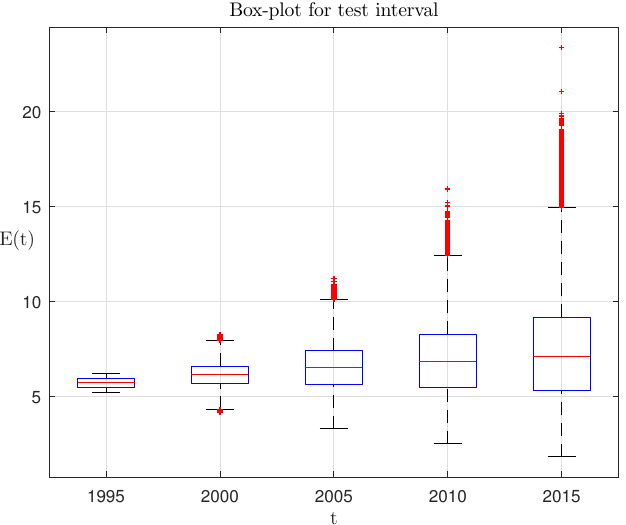
Figure 5: 1, the ensemble-average trajectory; 2, UN projection; 4, the boundaries of the interquartile range (IQR zone). The corresponding box-plot is presented in Figure 6.